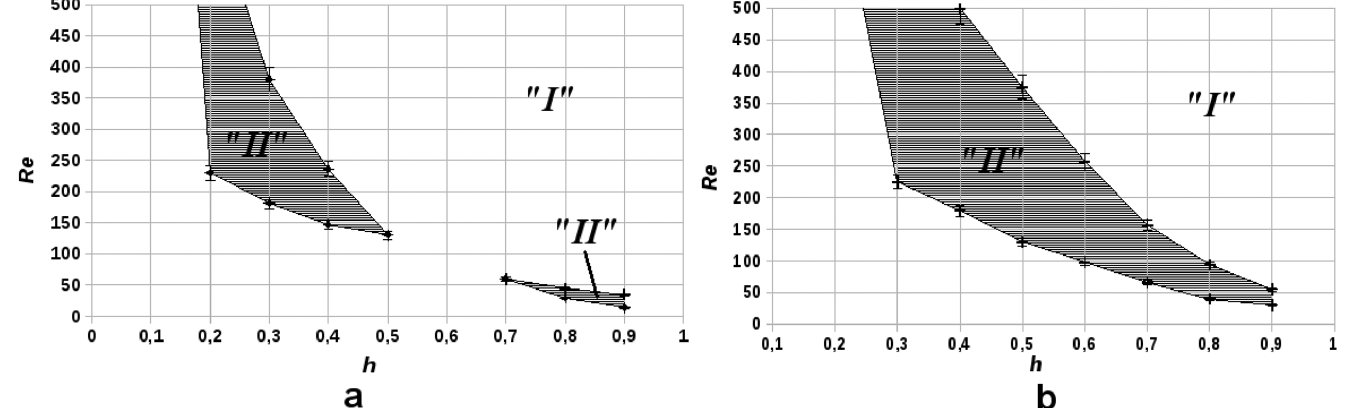
~ d , the non-dimensional plaque ~ d ¼ 0 : 3 ,